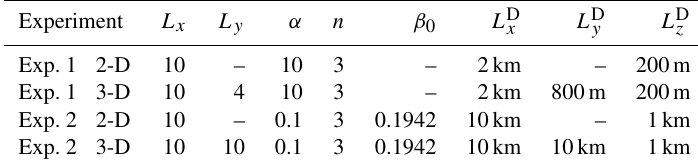
Table 1. Experiments 1 and 2: non-dimensional model parameters and the dimensional values (cid:0) D (cid:1) for comparison. Experiment L x